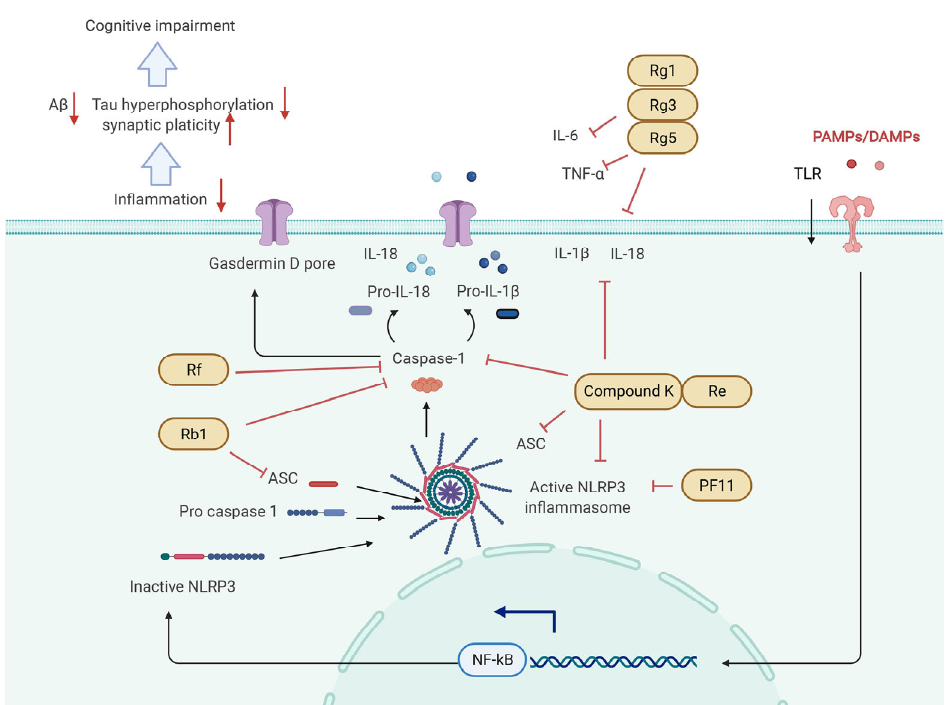
Figure 6. Molecular mechanisms of regulating NF- κ B/NLRP3 pathway by ginsenosides in treating cognitive impairment in the pathological model. NF- κ B pathway can be inhibited by ginsenosides via multiple ways: ( 1 ) Rf, Rb1, compound K, and Re inhibit the expression of caspase-1 to further reduce the level of IL-18 and IL-1 β . ( 2 ) Rb1, compound K, and Re inhibit the expression of ASC, an important factor for formatting NLRP3 inflammasome. ( 3 ) Compound K, Re, and PF11 can directly suppress activated NLRP3 inflammasome. ( 4 ) Rg1, Rg3, Rg5, compound K, and Re downregulate the level of IL-6, TNF- α , IL-18, and IL-1 β . All ginsenosides can attenuate the inflammatory state and further improve synaptic plasticity and decrease A β deposition and tau